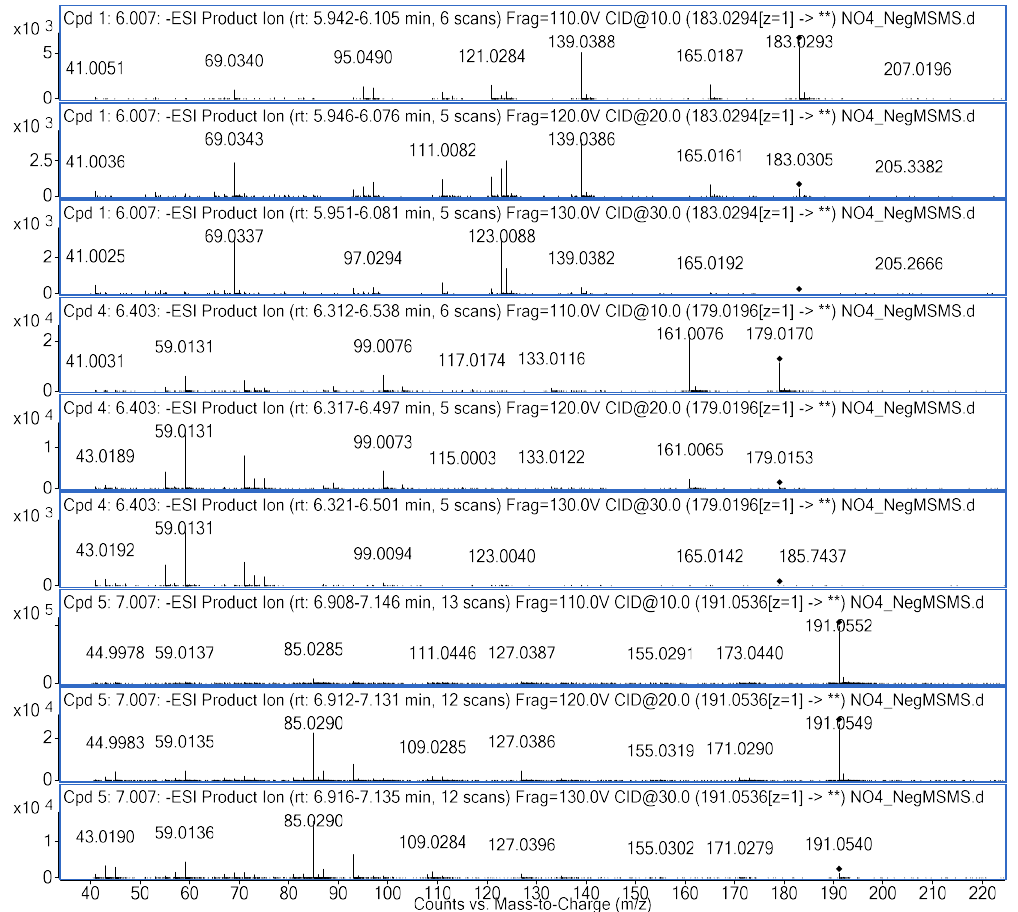
Figure 4. Target MS / MS analysis by UPLC-Q-TOF-MS of the hydrolysates of 3-CQA treated with ammonium hydrogen carbonate. MS / MS data for 3-CQA was obtained in negative ESI mode. MS /